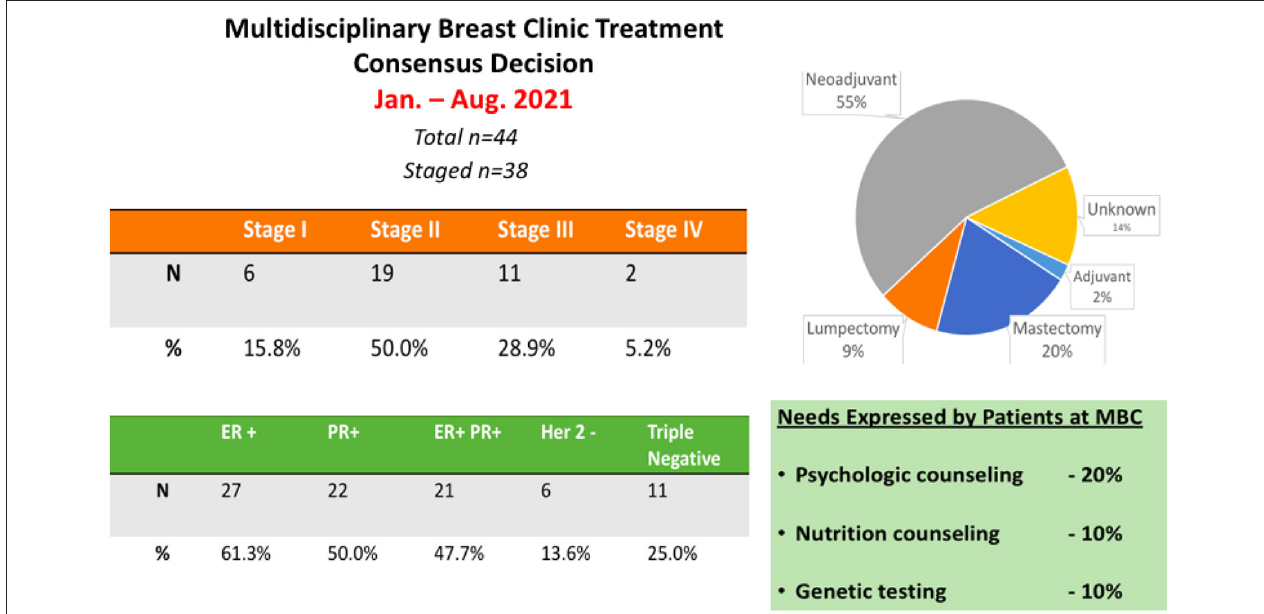
FIGURE 1 | Summary of the data collected from the MBC clinics at AKUHN over a period of 6